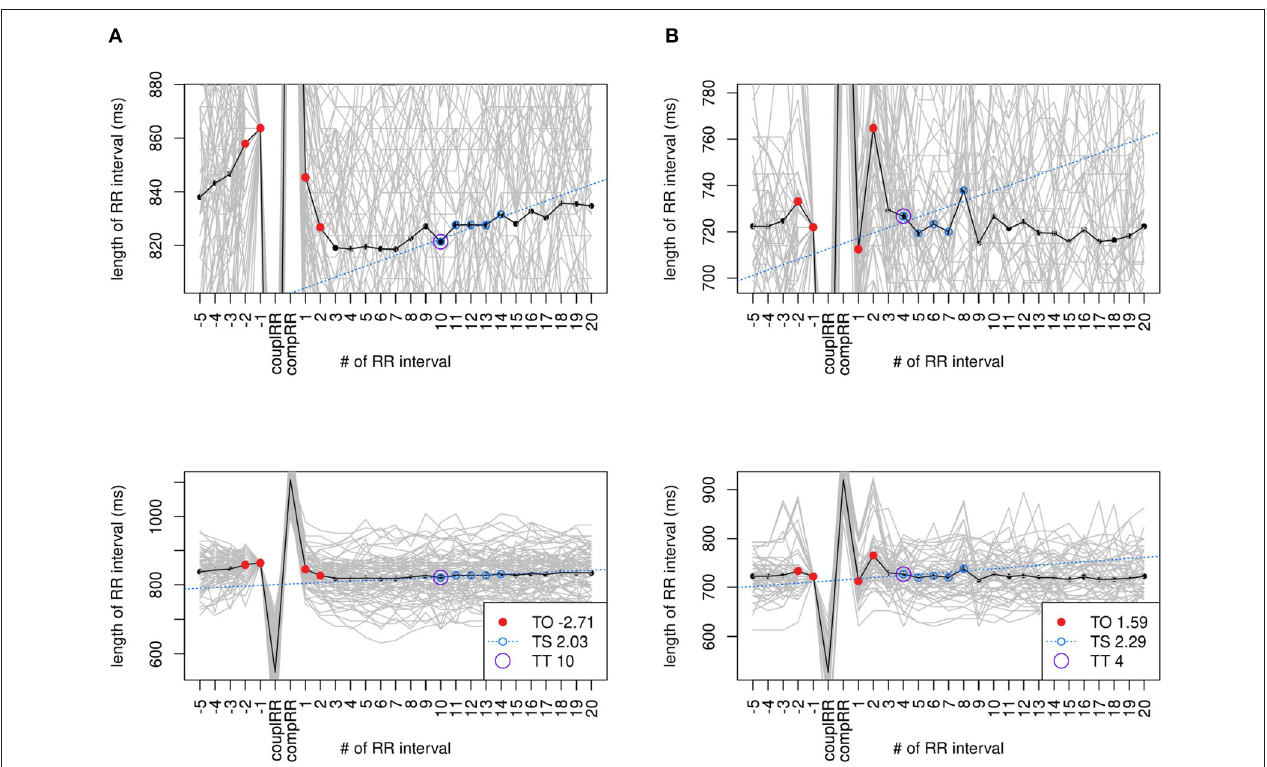
FIGURE 3 | stVPCS files without distinct HRT. Exemplary tachograms of two files used to calculate the stVPCS that do not show distinct HRT. Both files are in class HRTB. The upper row shows a zoomed in tachogram, the row below the respective tachogram zoomed out. Data: (A) s20491 from LTSTDB and (B) chf202 from CHF2DB .